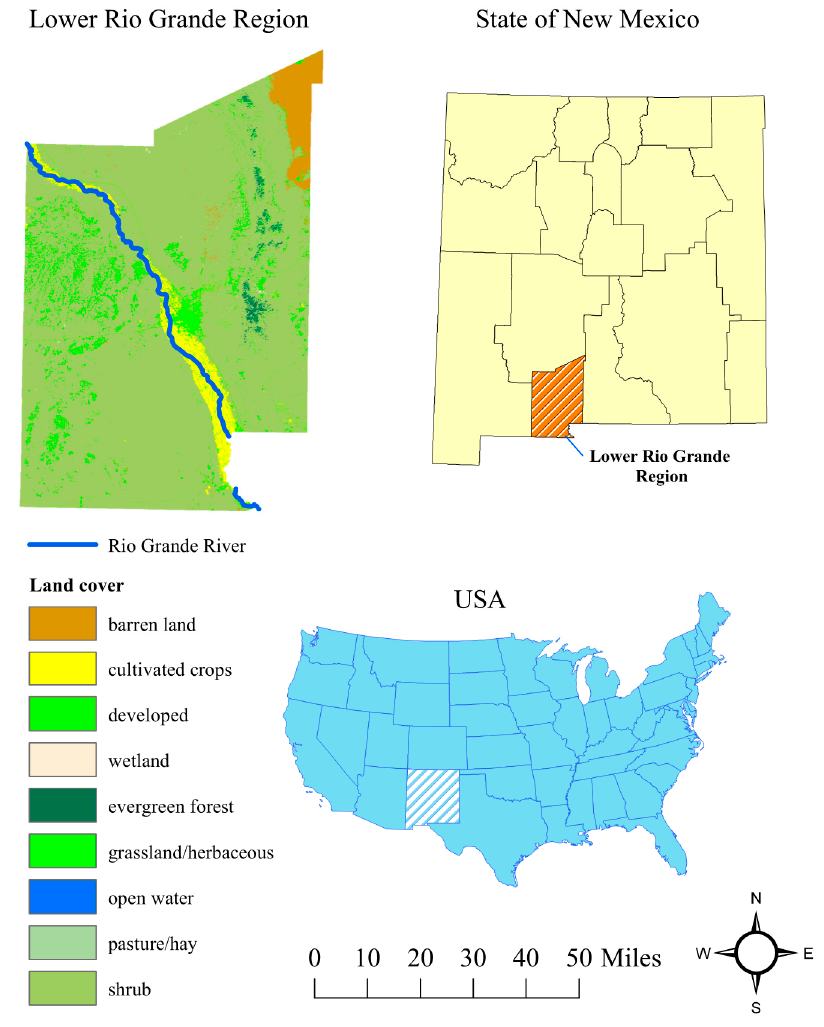
Figure 1. Generalized map of the lower Rio Grande region, its location in the US, and land cover.